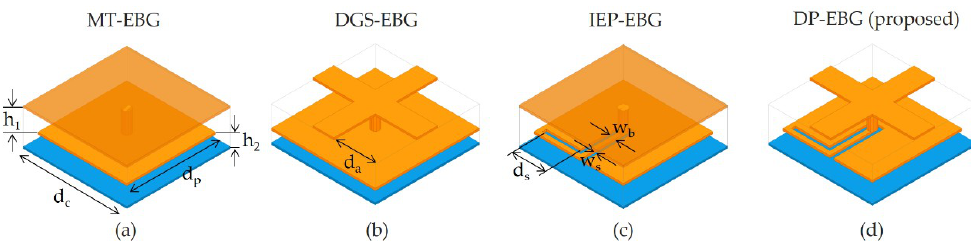
Figure 6. Unit cells of (a) mushroom-type (MT)–, (b) defected ground structure (DGS)–, (c) inductance-enhanced patch (IEP)–, and (d) DP–EBG structures for stopband comparisons.